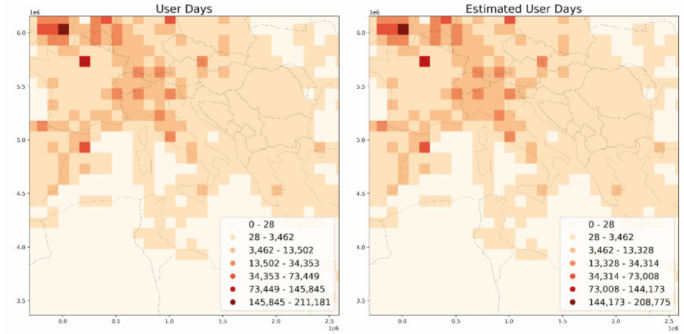
Figure 4. Comparison of automatic classification of raw and HLL user days for Europe (100 km